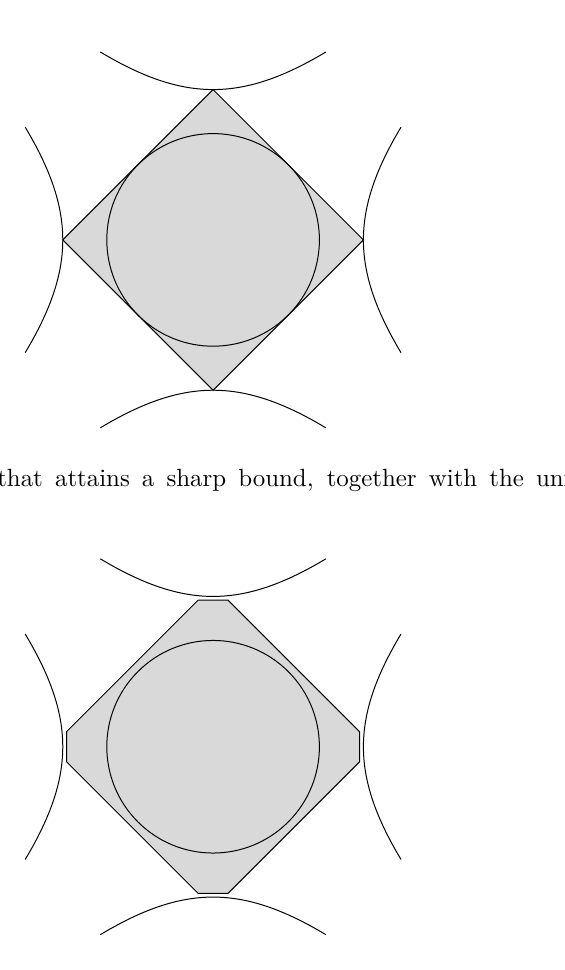
Figure 5 . An octagon 2 S ε such that f (0 , 0) > 0 , together with the unit circle and the hyperbolas x 2 − ¯ x 2 = ± 2